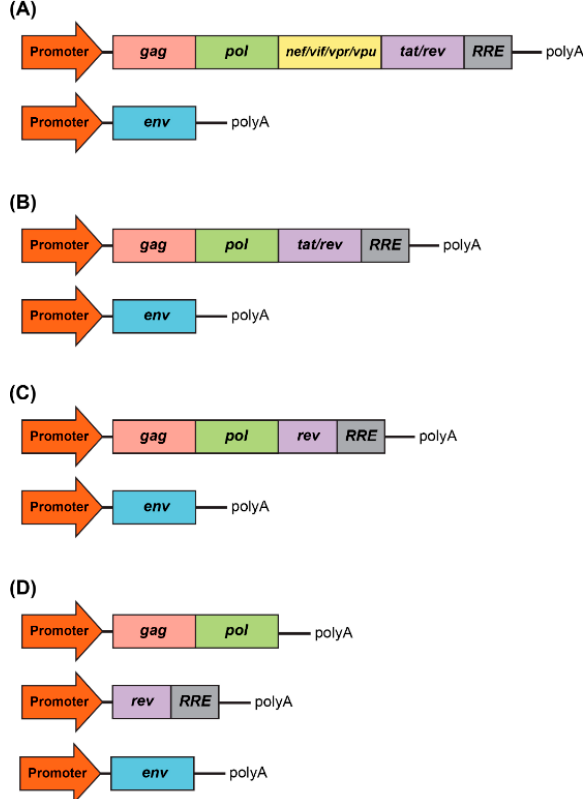
Figure 2. Development of packaging system for lentiviral production. ( A ) First generation included all accessory genes, nef, vif, vpr, and vpu, and the regulatory proteins, tat and rev. RRE is the rev response element. ( B ) Second generation excluded all accessory genes, nef, vif, vpr, and vpu. ( C ) Third generation excluded the tat regulatory protein. ( D ) Fours generation is characterized by the split of the gag/pol and rev sequences into two different cassettes, which evidently benefits the vector safety.